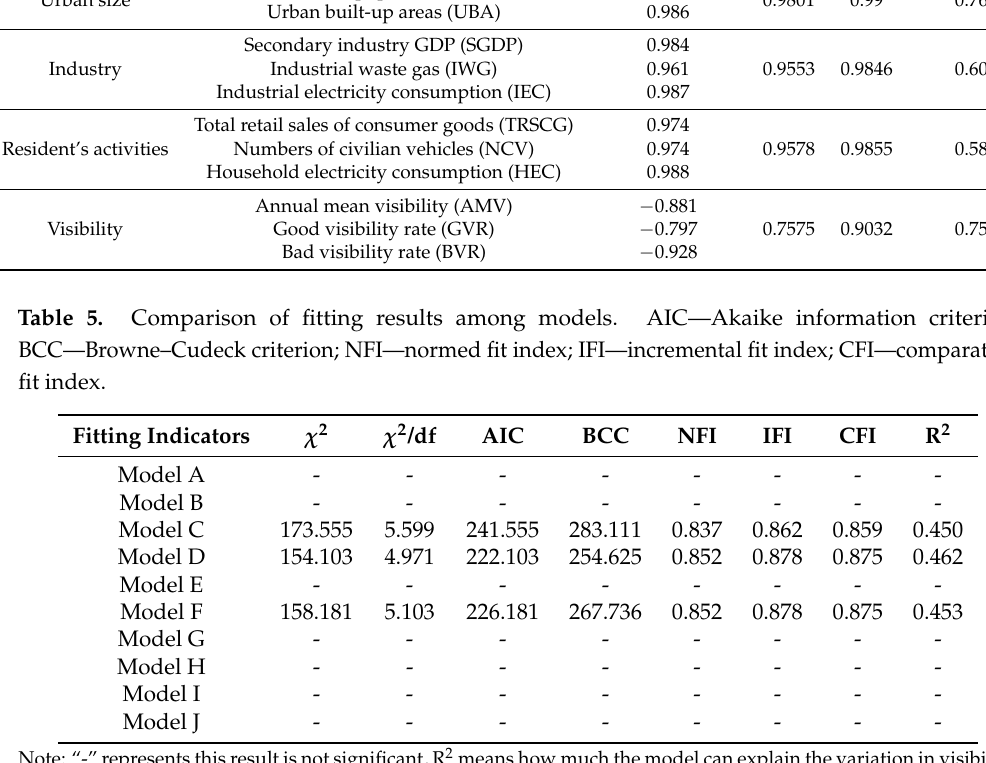
Table 4. Test of measurement scale. CR—composite reliability; AVE—average variance extracted.